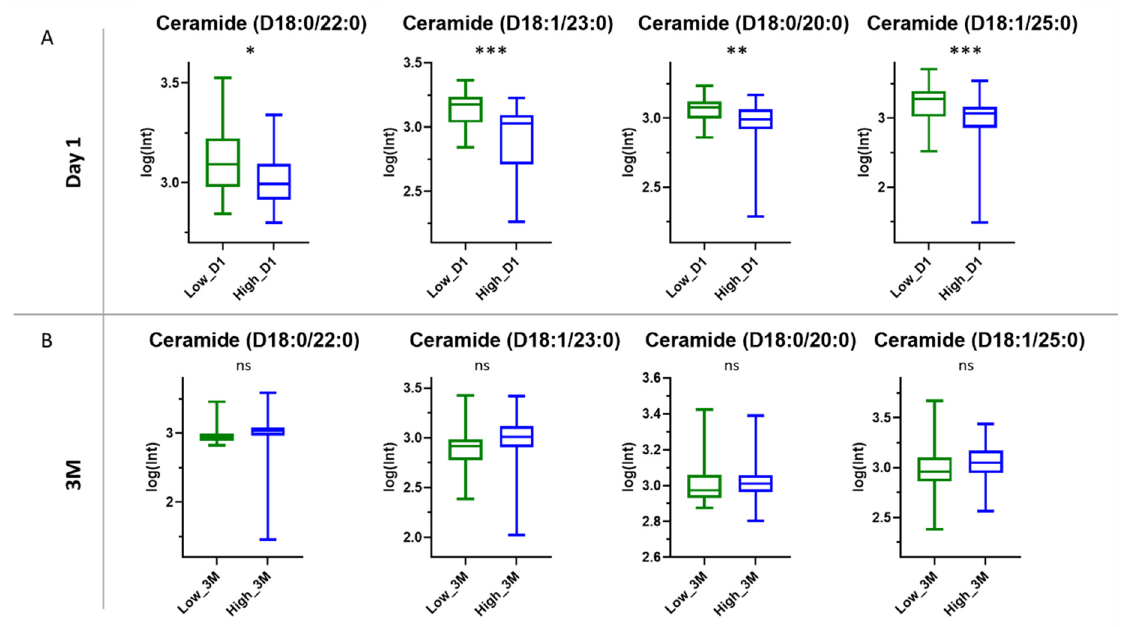
Figure 6. Box and whiskers plots of the detected ceramides for the low vs. high responders. ( A ) Day 1: The differences were statistically significant; p -values < 0.05. ( B ) three months after the first dose (3M): The differences were not statistically significant; p -values > 0.05. Asterisks indicate statistical significance: *** 0.0001 < p < 0.001, ** 0.001 < p < 0.01, * 0.01< p < 0.05; ns: not significant.